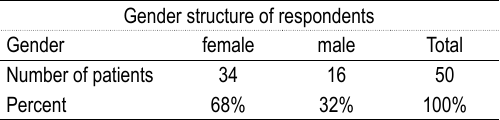
Table 2. Gender structure of respondents Gender structure of respondents